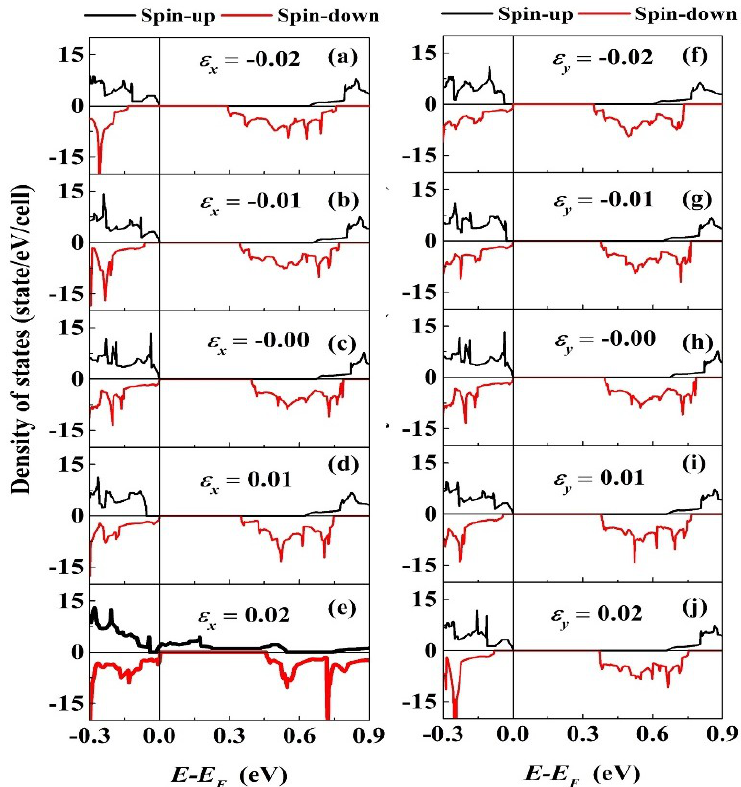
Figure 8. The spin polarized total density states of the PbPd 0.75 Co 0.25 O 2 slab with different strain ε x ( ε y ) : ( a – e ) along the x-axis, and ( f – j ) along the y-axis external uniaxial strain directions.